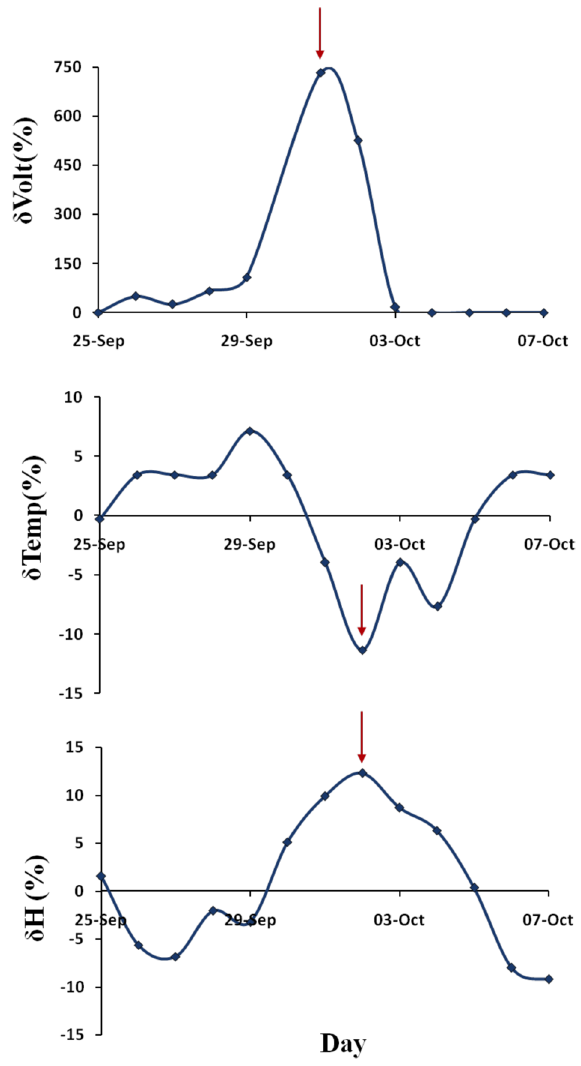
Figure 11. Percentage increase in magnitudes of over horizon sig- nal amplitudes (in volt) observed at GU for the days covering Janu- ary 9, 2013, EQ event, along with deviations of temperature and humidity from the average magnitude. Note that with the increase of signal strength by 1000% on January 8, the humidity shows en- hancement by 30%, in synchronization with the decrease of tem- perature by 40%. The red arrow marks the simultaneity between these events, on January 8.